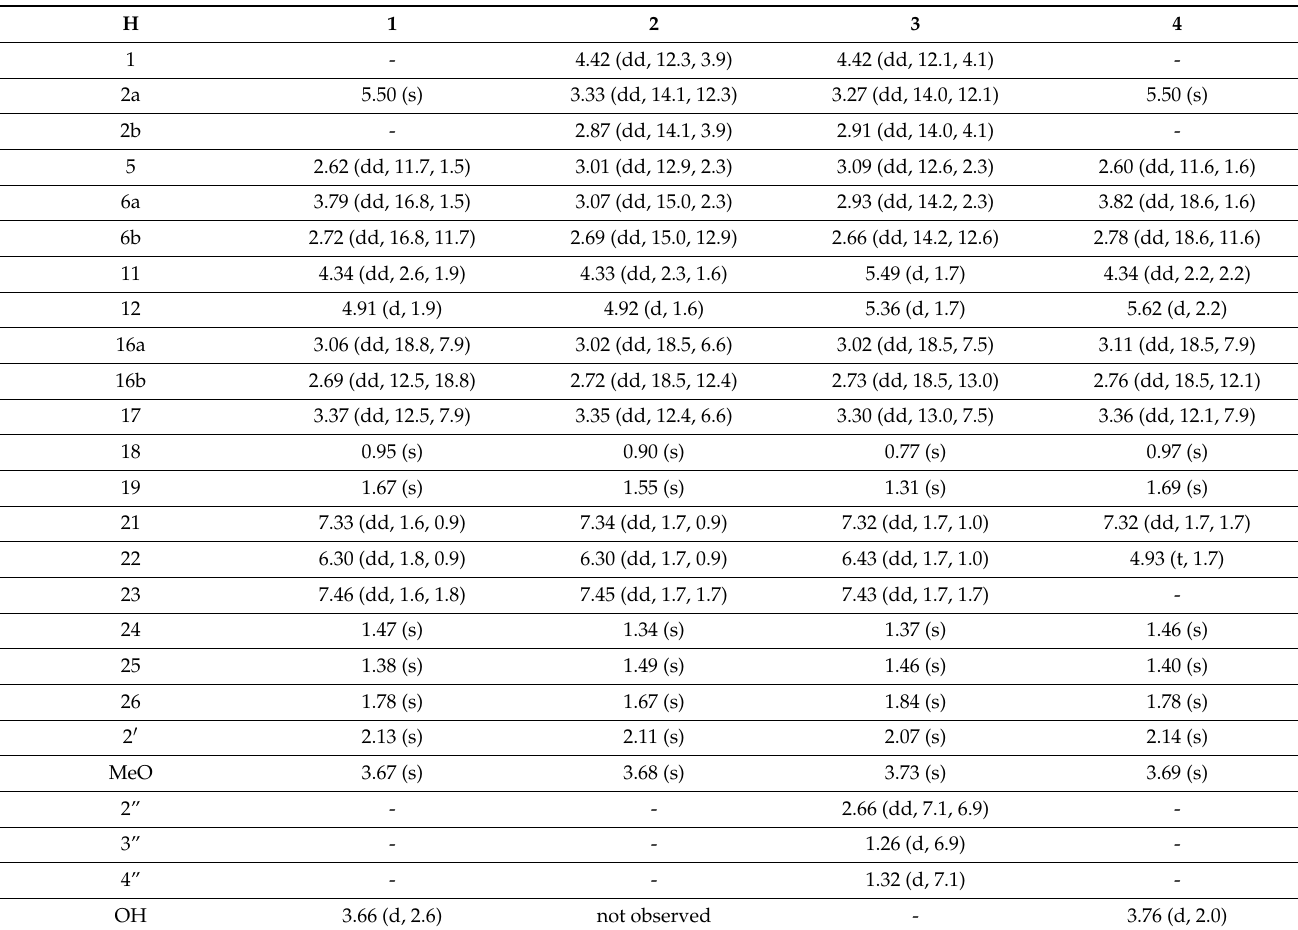
Figure 5. NOESY correlations observed with compounds 1 – 4 . Table 1. 1 H NMR spectroscopic data for 1 – 4 recorded in CDCl 3 . The chemical shifts are in ppm, multiplicities and coupling constants (in Hz) are given in parentheses. The solvent signal at 7.27 ppm was used as a reference.